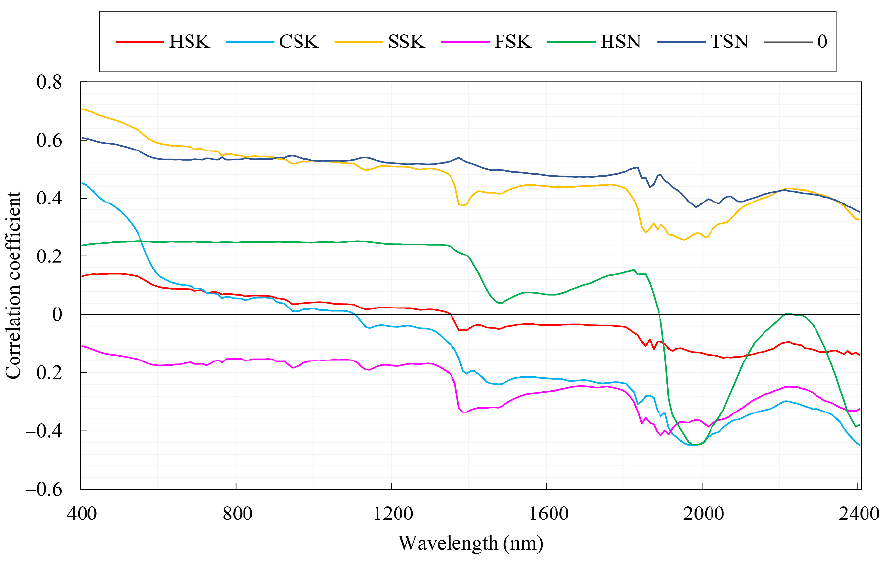
Figure 5. Correlation coefficient between the EC values and the reflectance spectra of various salinized soil types.